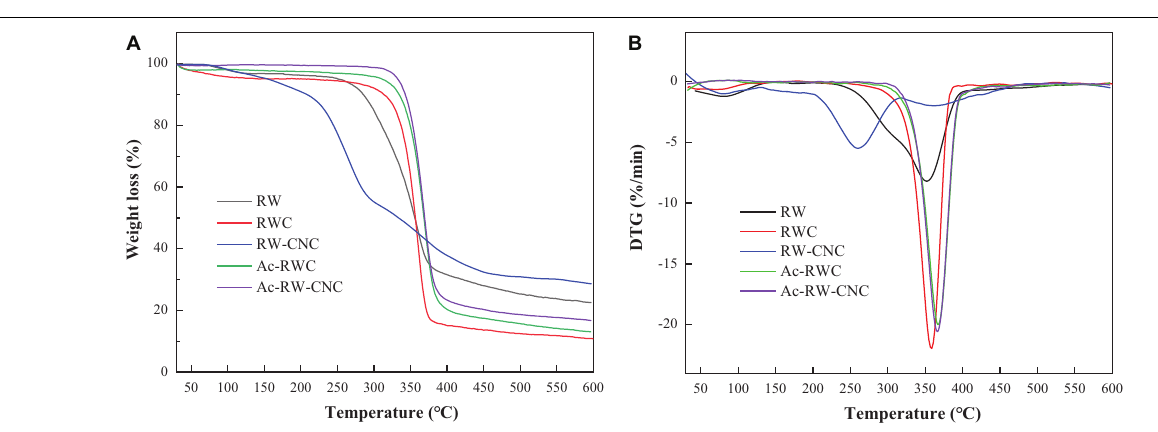
FIGURE 4 | SEM images of RW (A) and RWC (B) and TEM image of RW–CNC (C).